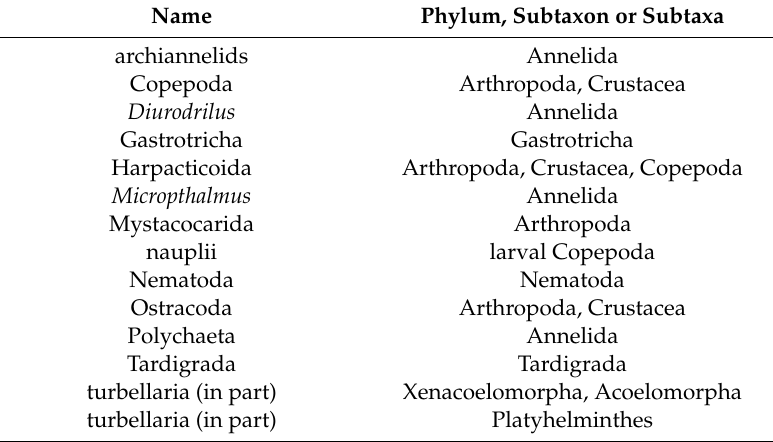
Table A1. Taxonomic and non-taxonomic group names used in the